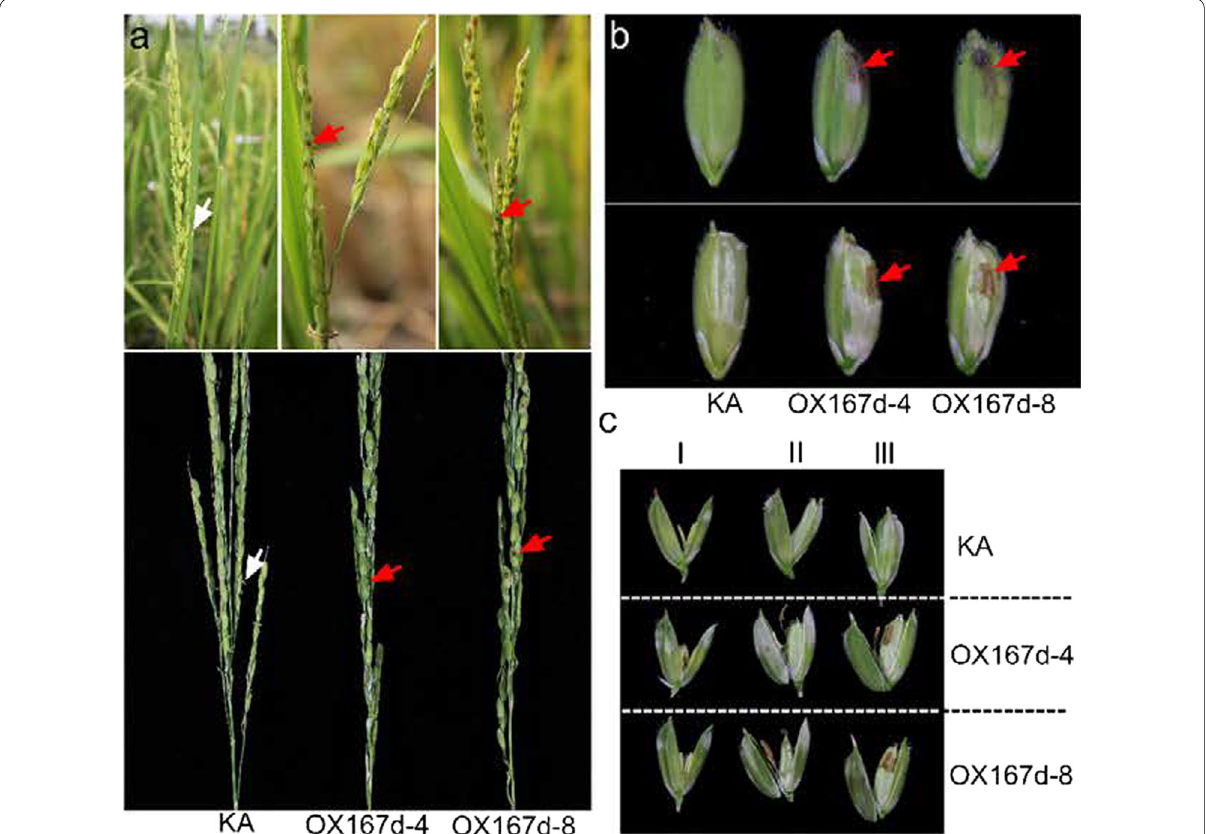
Fig. 1 Phenotypic analysis of the spikelets and flowers in OX167d. a The inheritance of cleistogamy in the OX167d lines. The white arrows indicate the anthers that move out from the flowers. Red arrows indicate the stamens that remain inside the spikelets, forming the black dots. b , c The inner view of the flowers at the different stages. The early filling stage ( c I), middle filling stage ( c II), and late filling stage ( b , c III). Red arrows indicate the